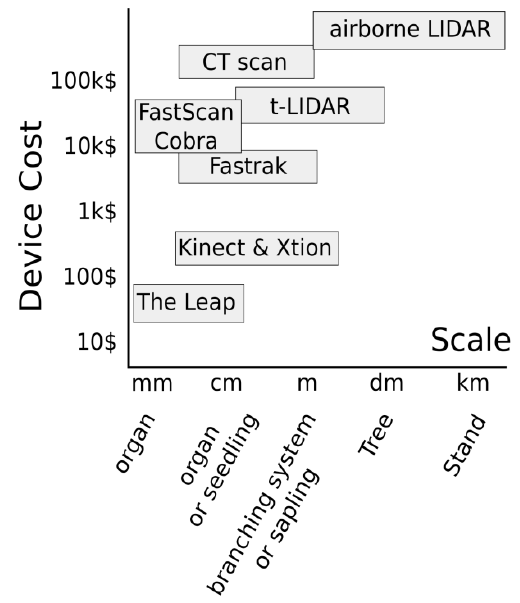
Figure 8. Illustration of devices used to generate 3D architectural data, their prices and the scale at which the generated data is most applicable to woody